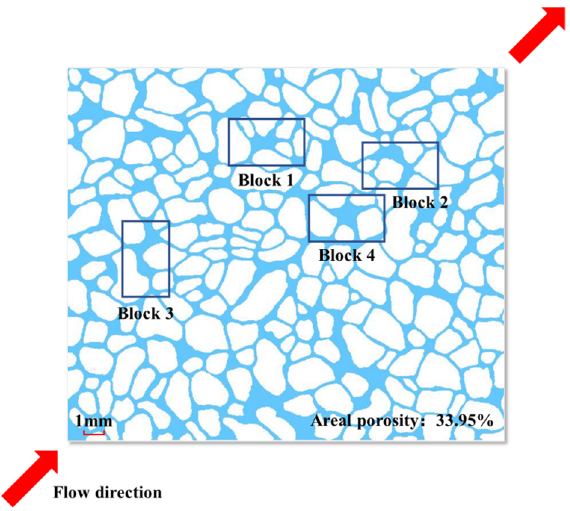
Figure 6. A photomask of micromodel with four blocks selected for analysis.